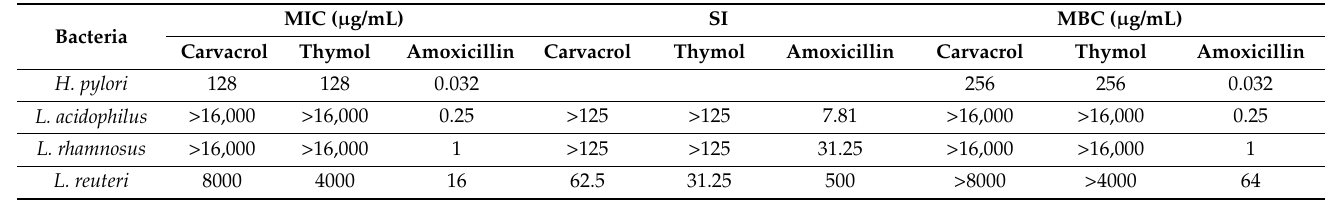
Table 2. Determination of the MIC, MBC, and SI * of carvacrol, thymol, and amoxicillin versus H. pylori ATCC43504, L. acidophilus ATCC SD5214, L. rhamnosus GG ATCC 53103, and L. reuteri DSM 17938.